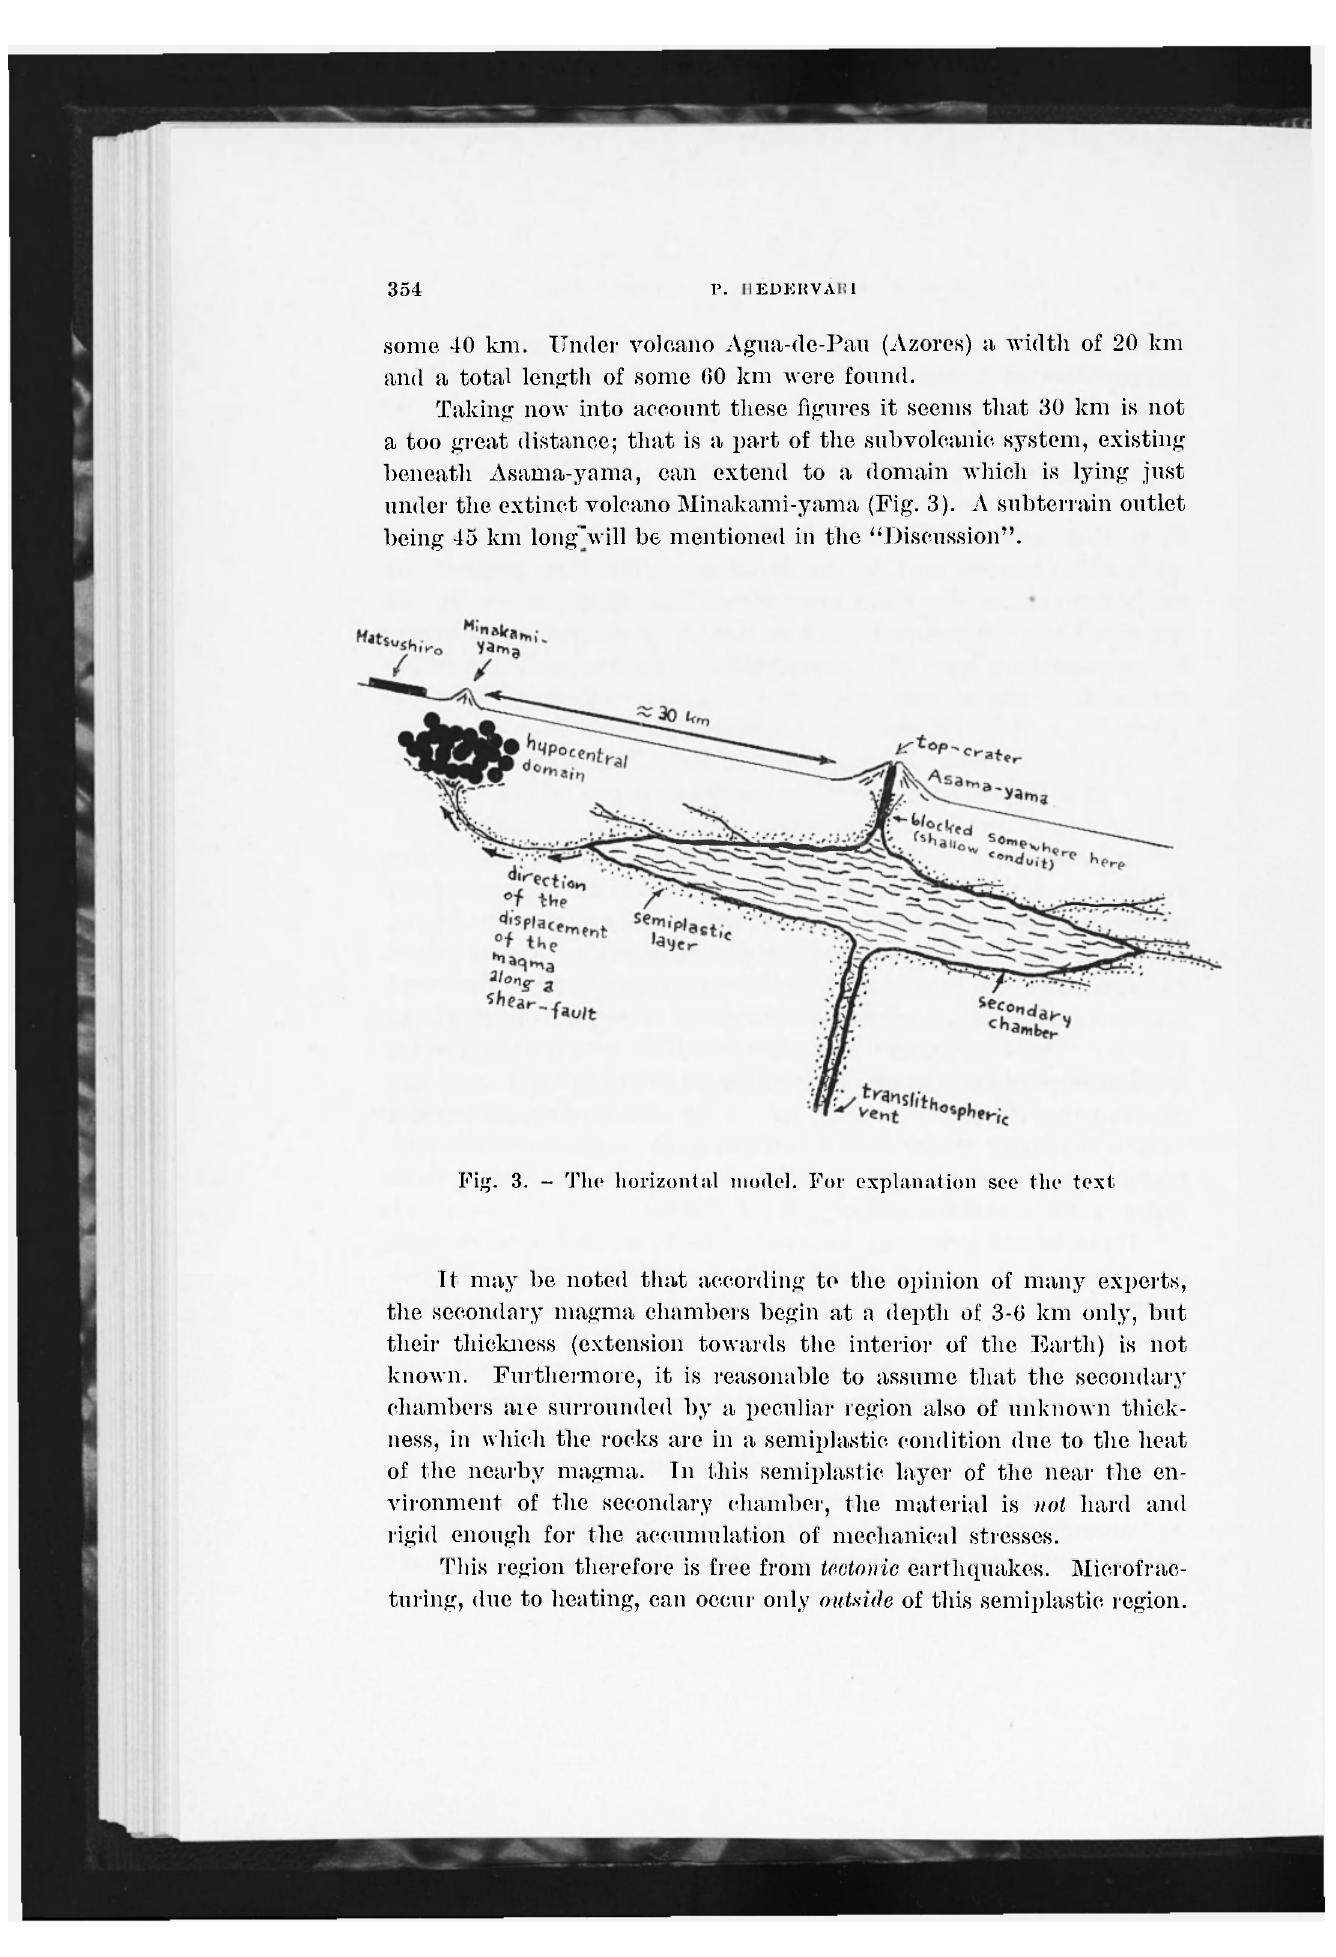
Fig. 3. - The horizontal model. For explanation see the